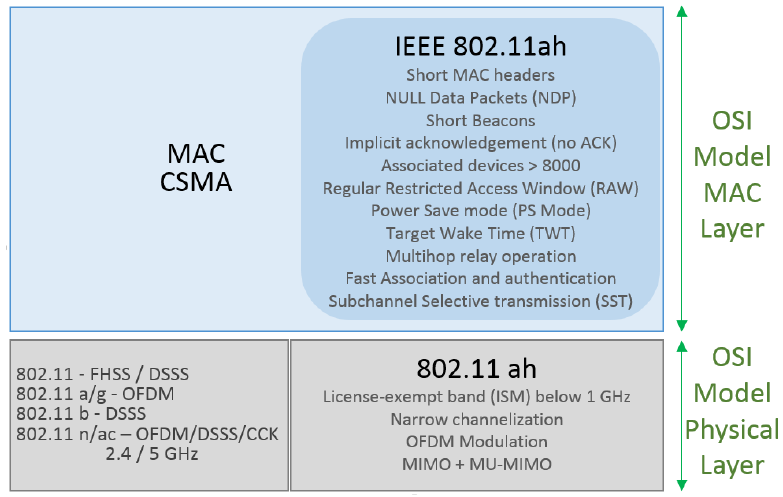
Figure 15. IEEE 802.11